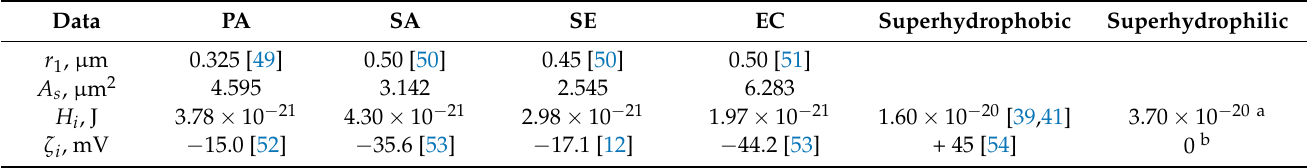
Table 7. Additional data used to determine Gibbs interaction energies via extended DLVO theory.